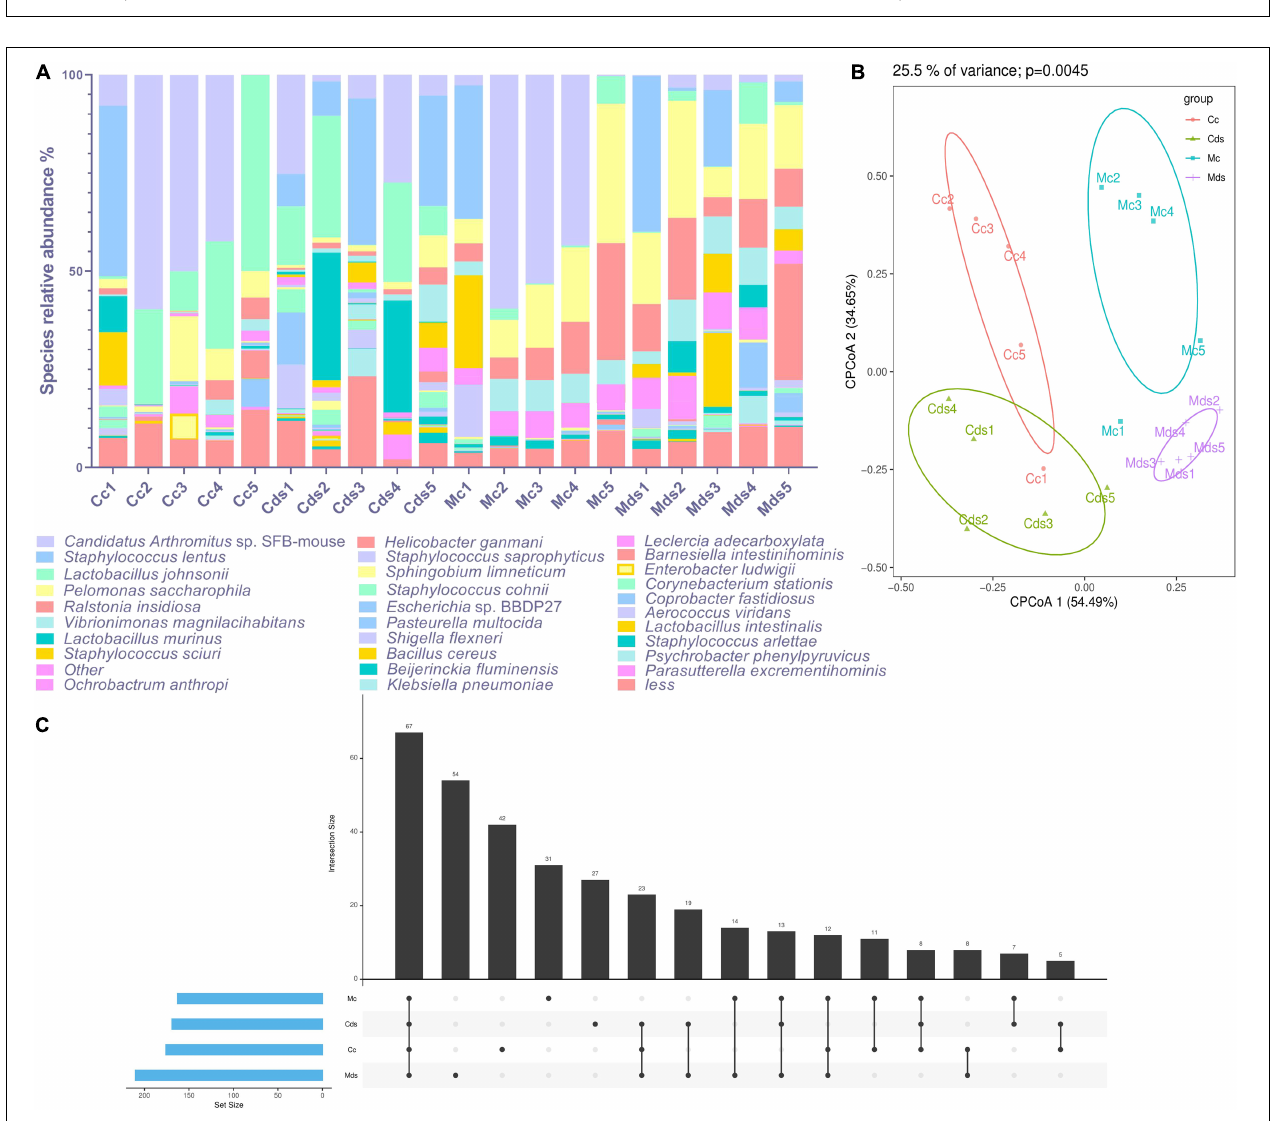
FIGURE 1 | Repeated stress-related diarrhea alters intestinal microbiota diversity and composition. (A) Box plots of observed operational taxonomic unit (OTUs). (B) Box plots of α -diversity index of OTUs (Chao1, Simpson, ACE, and Shannon). (C) Box plots of β -diversity index of PCoA1 and NMDS of OTUs, represented by the space distance among groups. (A–C) * P < 0.05, ** P < 0.01; N.S., not significant ( P > 0.05). (D) Relative mean abundance of (1) phyla, (2) class, (3) order, (4) family, and (5) genus in the intestinal contents and mucosa; * P < 0.05, ** P < 0.01, Wilcoxon rank sum test. Cc, intestinal contents in control mice; Cds, intestinal